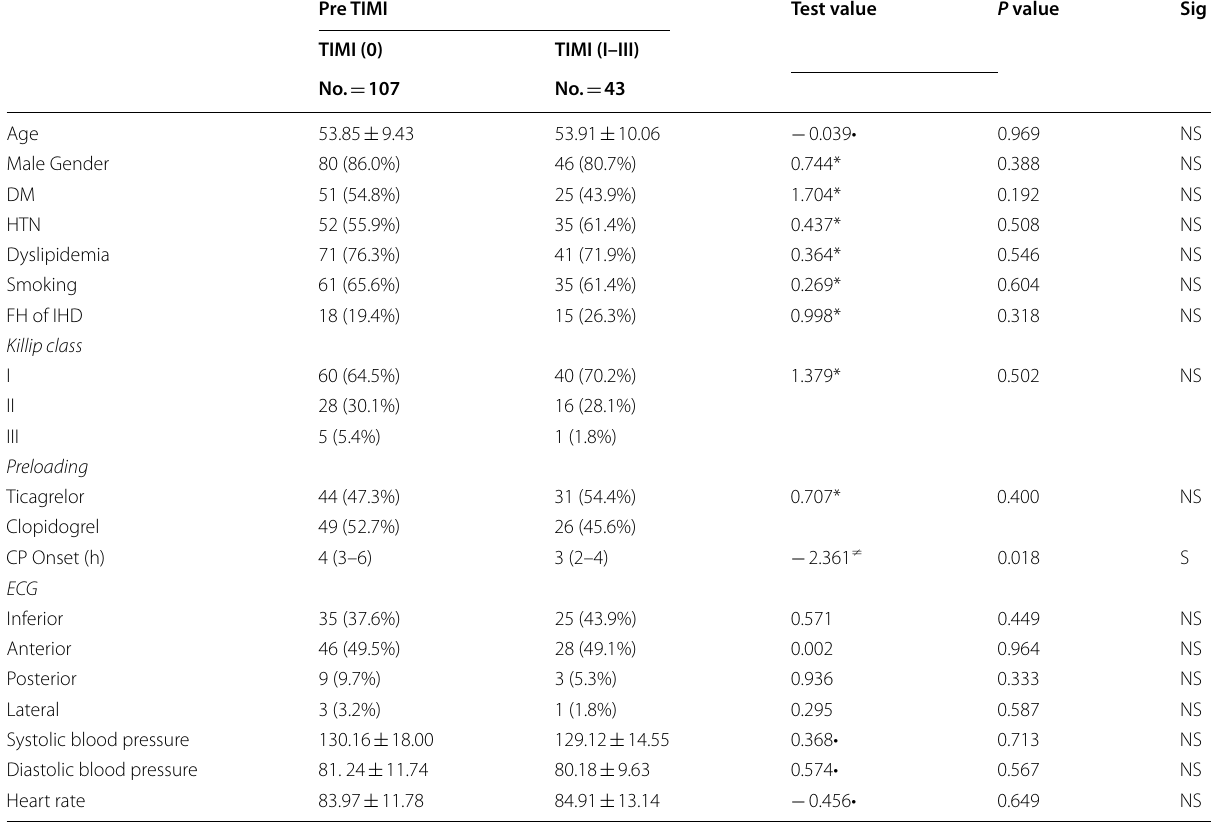
Table 2 Relation between pre TIMI flow grade and demographic/clinical data of the studied